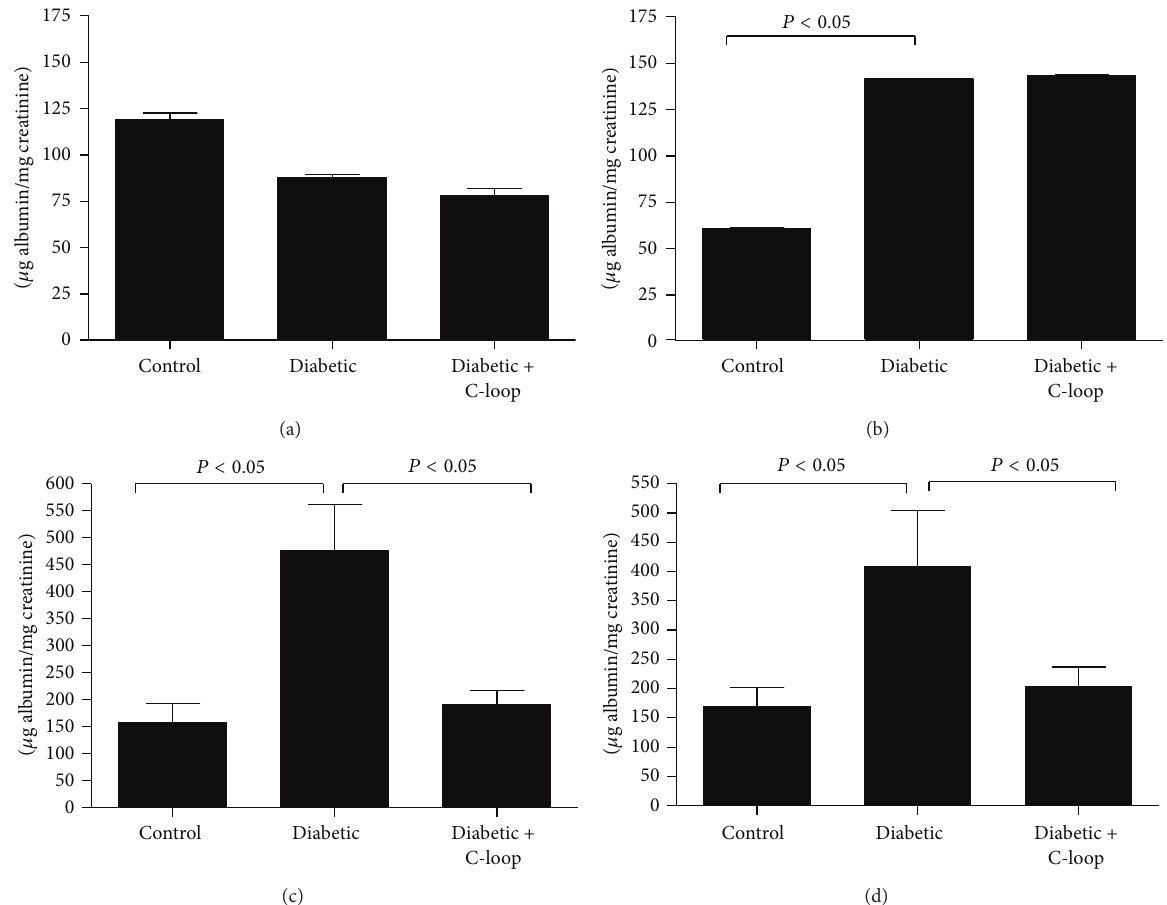
Figure 2: Urinary albumin and creatinine were measured in spot urine samples from all rats from each group ( 𝑛 = 15 ) at 4 time points (at the start of study week 0 (a), 4 weeks after the induction of hyperglycemia (b); control, 8 weeks of diabetes + with 4 wks vehicle (diabetic) or C-loop antibody treatment (c); control, 12 weeks of diabetes with 8 wks vehicle (diabetic); or 8 weeks of C-loop antibody treatment (d)). The results are shown as 𝜇 g albumin/mg creatine (mean ± SEM). 𝑃 < 0.05 when the vehicle-treated hyperglycemic animals (diabetic) were compared with controls (con) or the hyperglycemic animals treated with the C-loop antibody (diabetic +